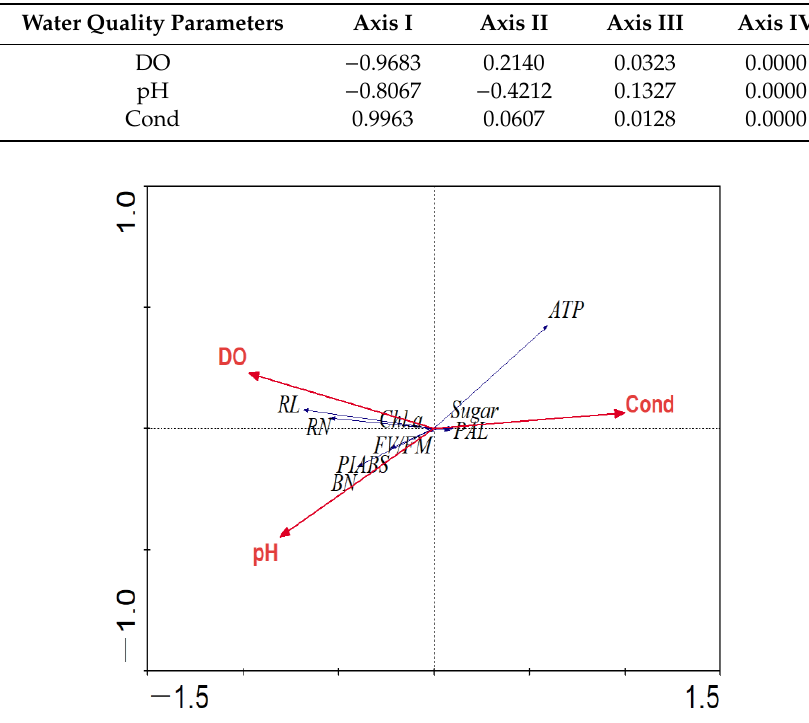
Figure 6. Biplot of the first two axes of the RDA (redundancy analysis) for water quality parameters associated with physiological and biochemical characteristics of Myriophyllum spicatum . The abbreviations